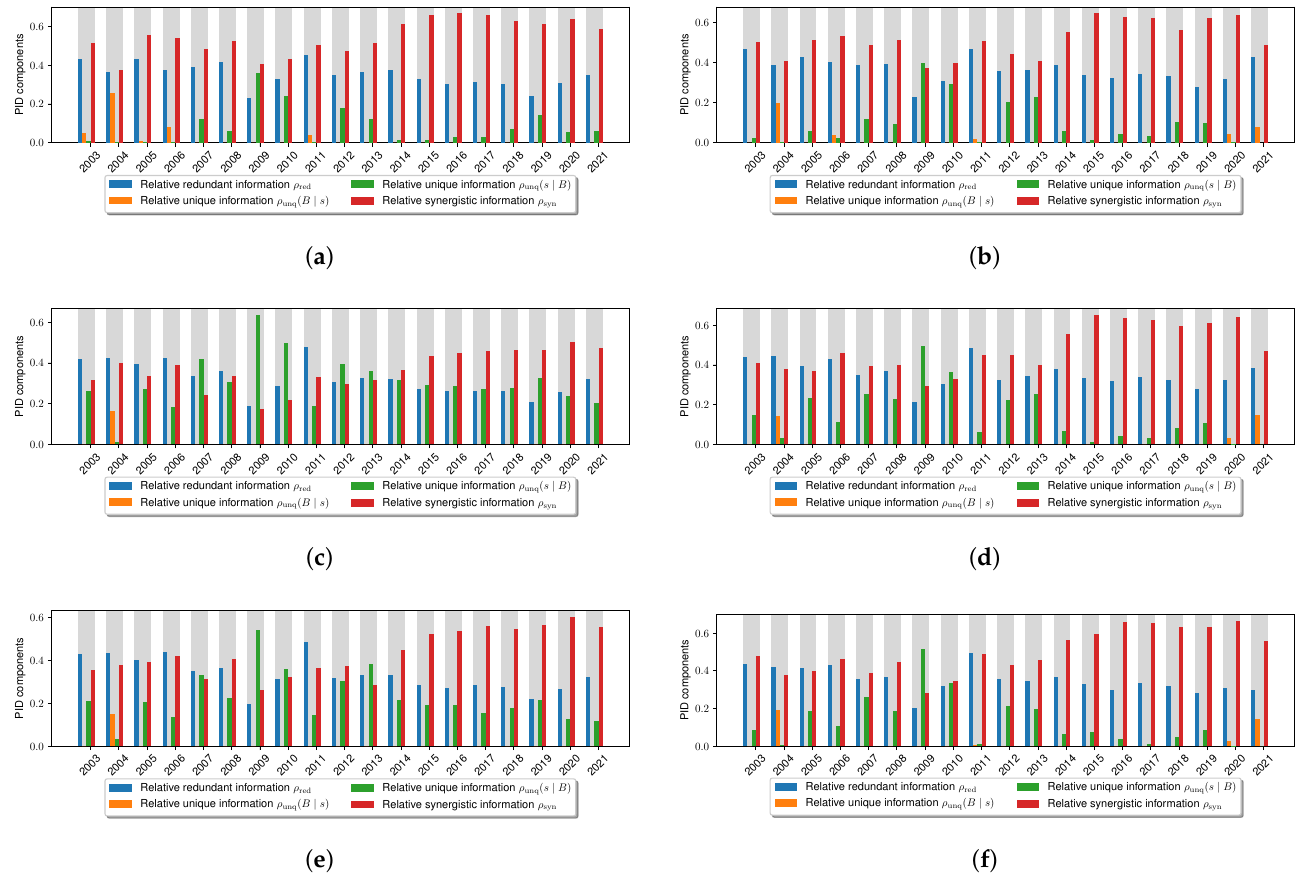
Figure 9. PID decomposition components with different two-hop link predictors. Shown are the (cid:0) (cid:1) a miss ; B , s relative PID measures (see legend) of the joint mutual information I , namely, the relative redundant information ρ red , the relative synergistic information ρ syn , and two types of relative s ) and ρ unq ( s B ) . The microscopic variable s for each sub-figure unique information, ρ unq ( B | | was calculated based on a type of two-hop link predictor, and the macroscopic variable B for all the sub-figures was calculated in the same way (i.e., the link density of communities). It can be observed that, in most years, especially in the middle and late stages of the development of ITS, the relative synergistic information ρ syn plays a dominant role. Such observation implies that the (cid:0) (cid:1) a miss B , s joint conditional distribution p could be more informative than any of the two marginal | (cid:0) (cid:1) (cid:0) (cid:1) a miss B a miss s conditional distributions, p and p . ( a ) Two-hop link predictor: WCN. ( b ) Two- | | hop link predictor: rWCN. ( c ) Two-hop link predictor: WAA. ( d ) Two-hop link predictor: rWAA. ( e ) Two-hop link predictor: WRA. ( f ) Two-hop link predictor: